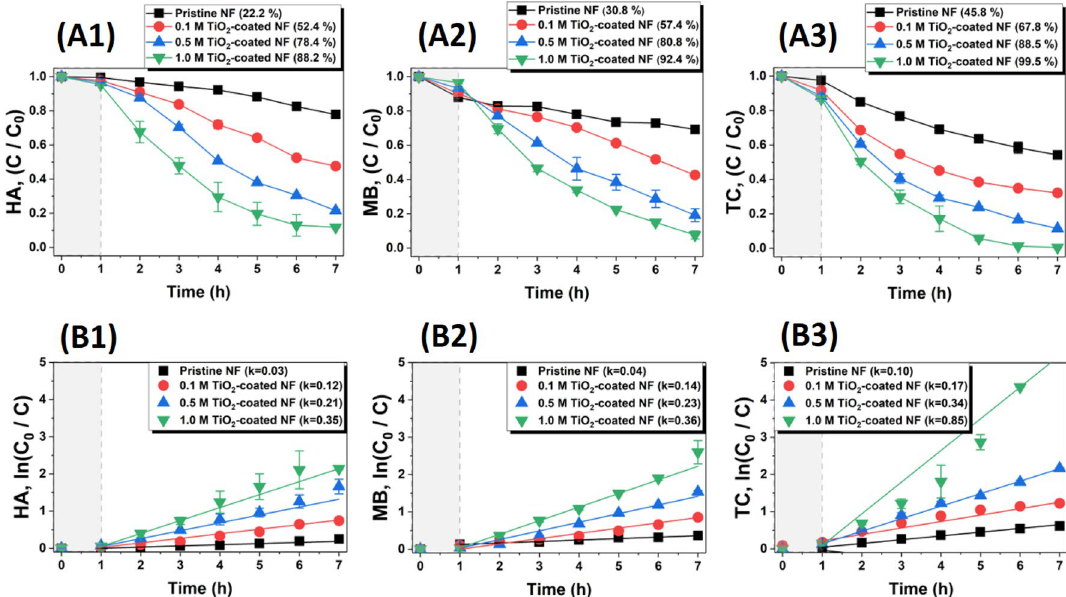
Figure 7. Adsorption/photocatalytic degradation of ( A1 ) HA, ( A2 ) MB, and ( A3 ) TC and apparent reaction rate of ( B1 ) HA, ( B2 ) MB, and ( B3 ) TC by YSZ/silica (pristine) and TiO 2 -coated YSZ/silica NF under UV-light